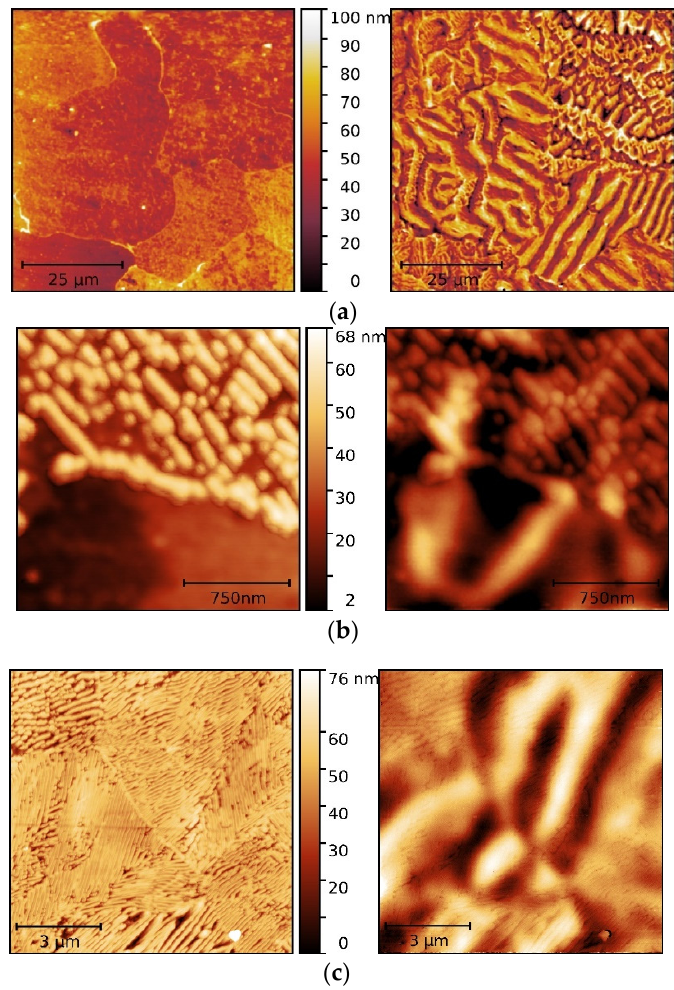
Figure 6. MFM observations of the topography ( left ) and magnetic domain patterns ( right ) of ( a ) fully ferritic; ( b ) proeutectoid ferrite-pearlite; and ( c ) fully pearlitic steel samples.